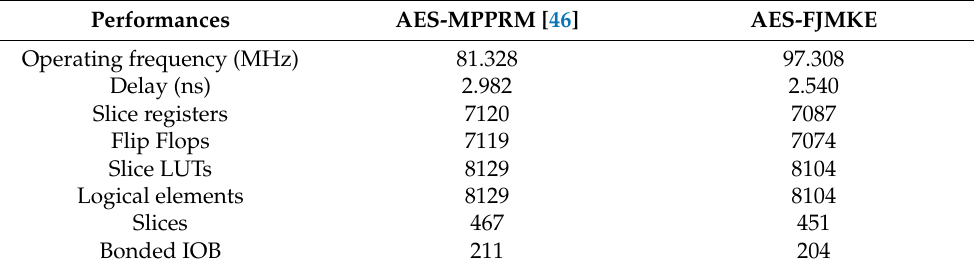
Table 13. Comparison of AES-FJMKE and AES-MPPRM for Kintex